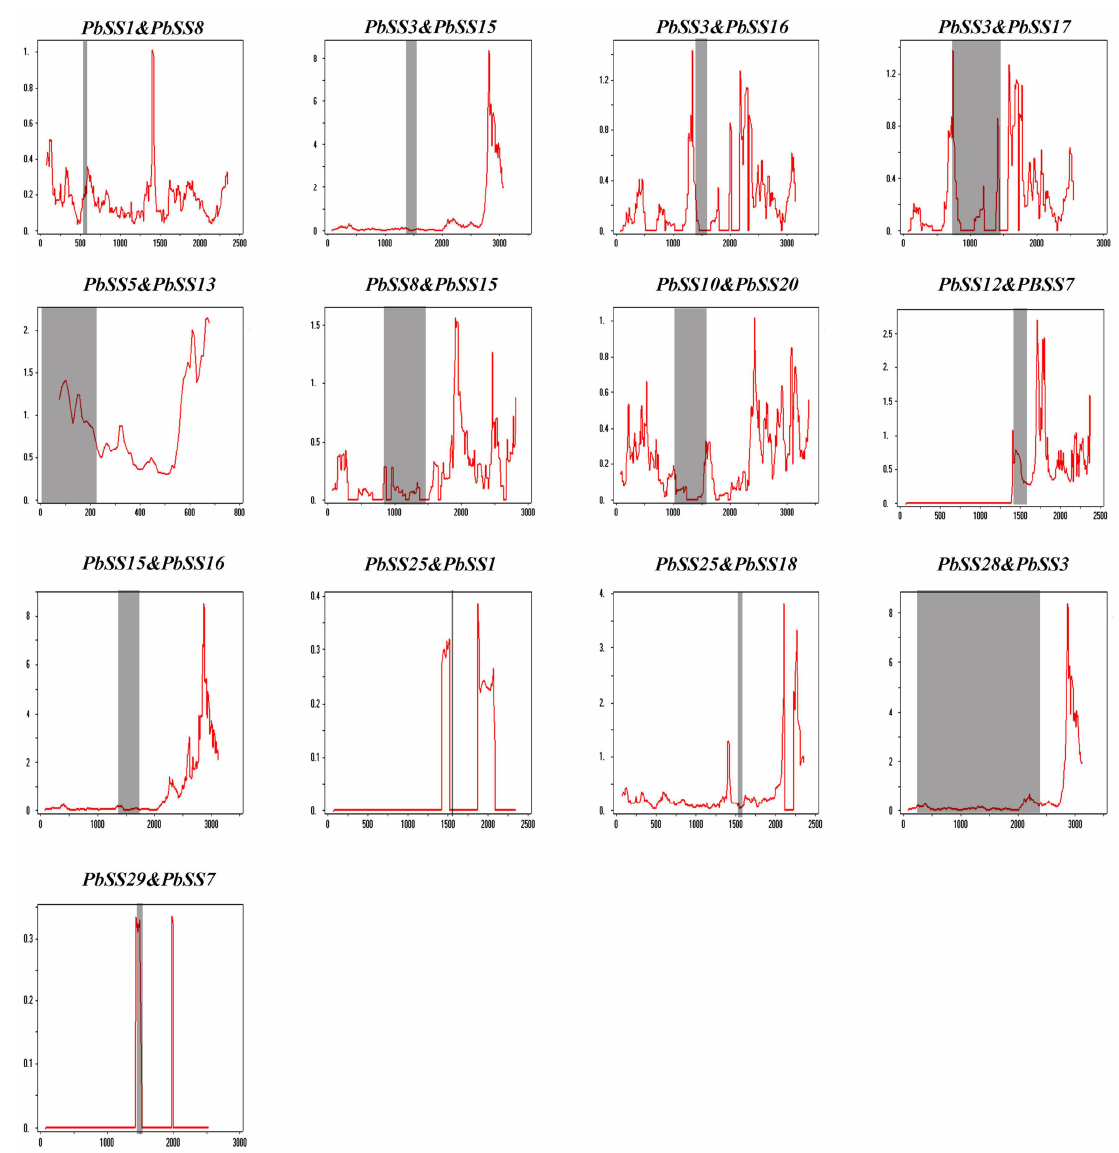
Figure 4. Sliding window plots of all duplicated PbSSs genes in pear. The window size is 150 bp, and the step size is 9 bp. The X-axis indicated the synonymous distance within each gene.